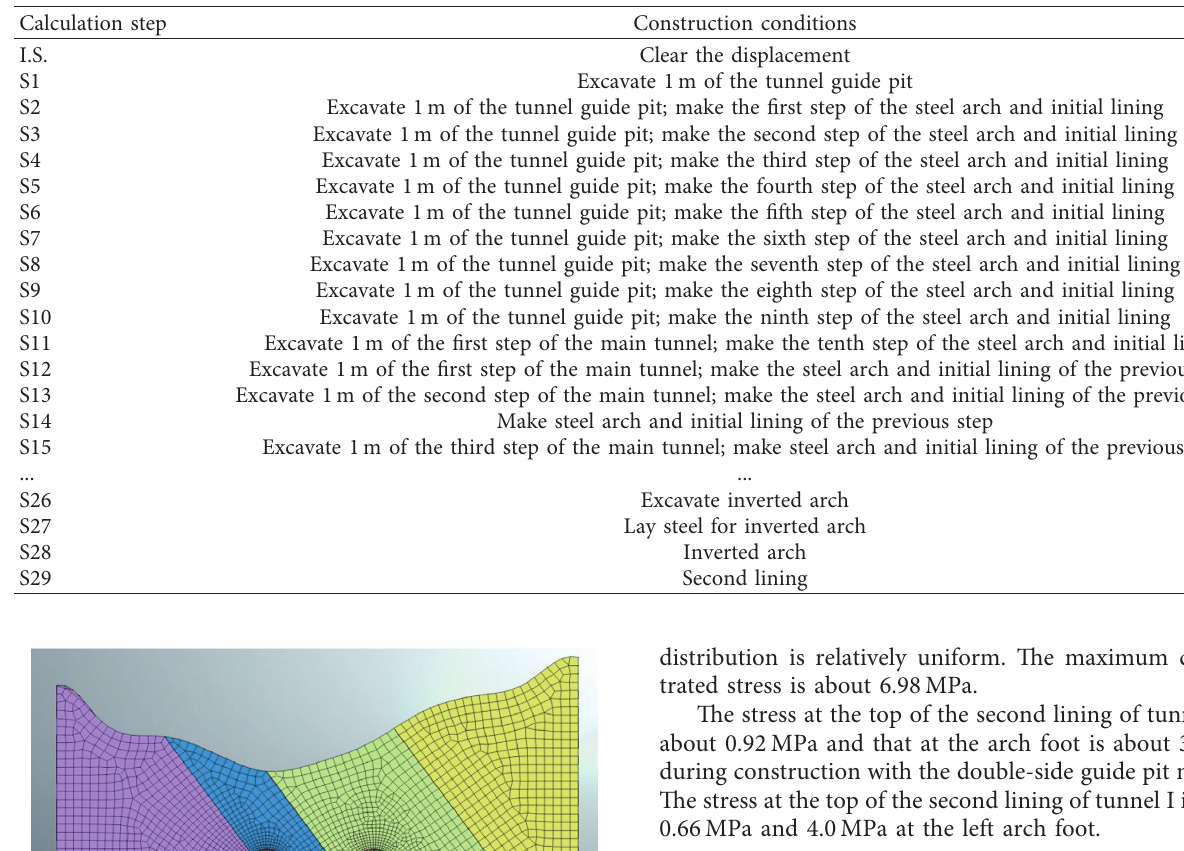
Table 4: Main calculation steps of single-side wall construction.